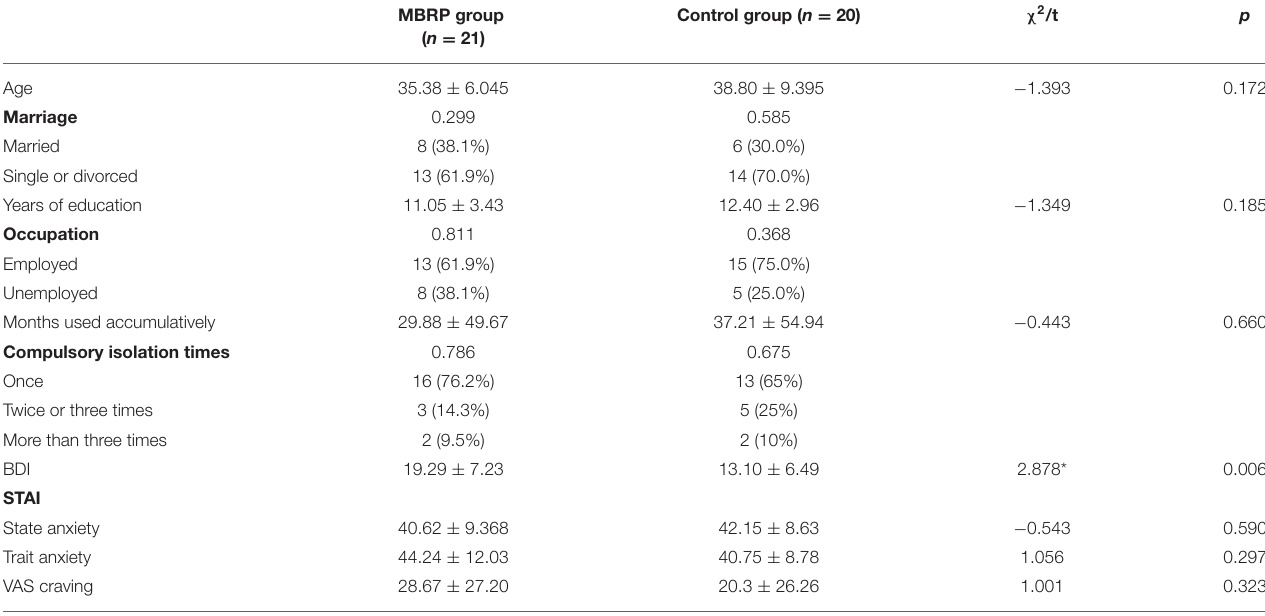
TABLE 1 | Baseline comparison of demographic variables, substance use situations, and all outcome variables between the MBRP group and the control group before the intervention [ M ± SD/n(%) ] ( N = 41).